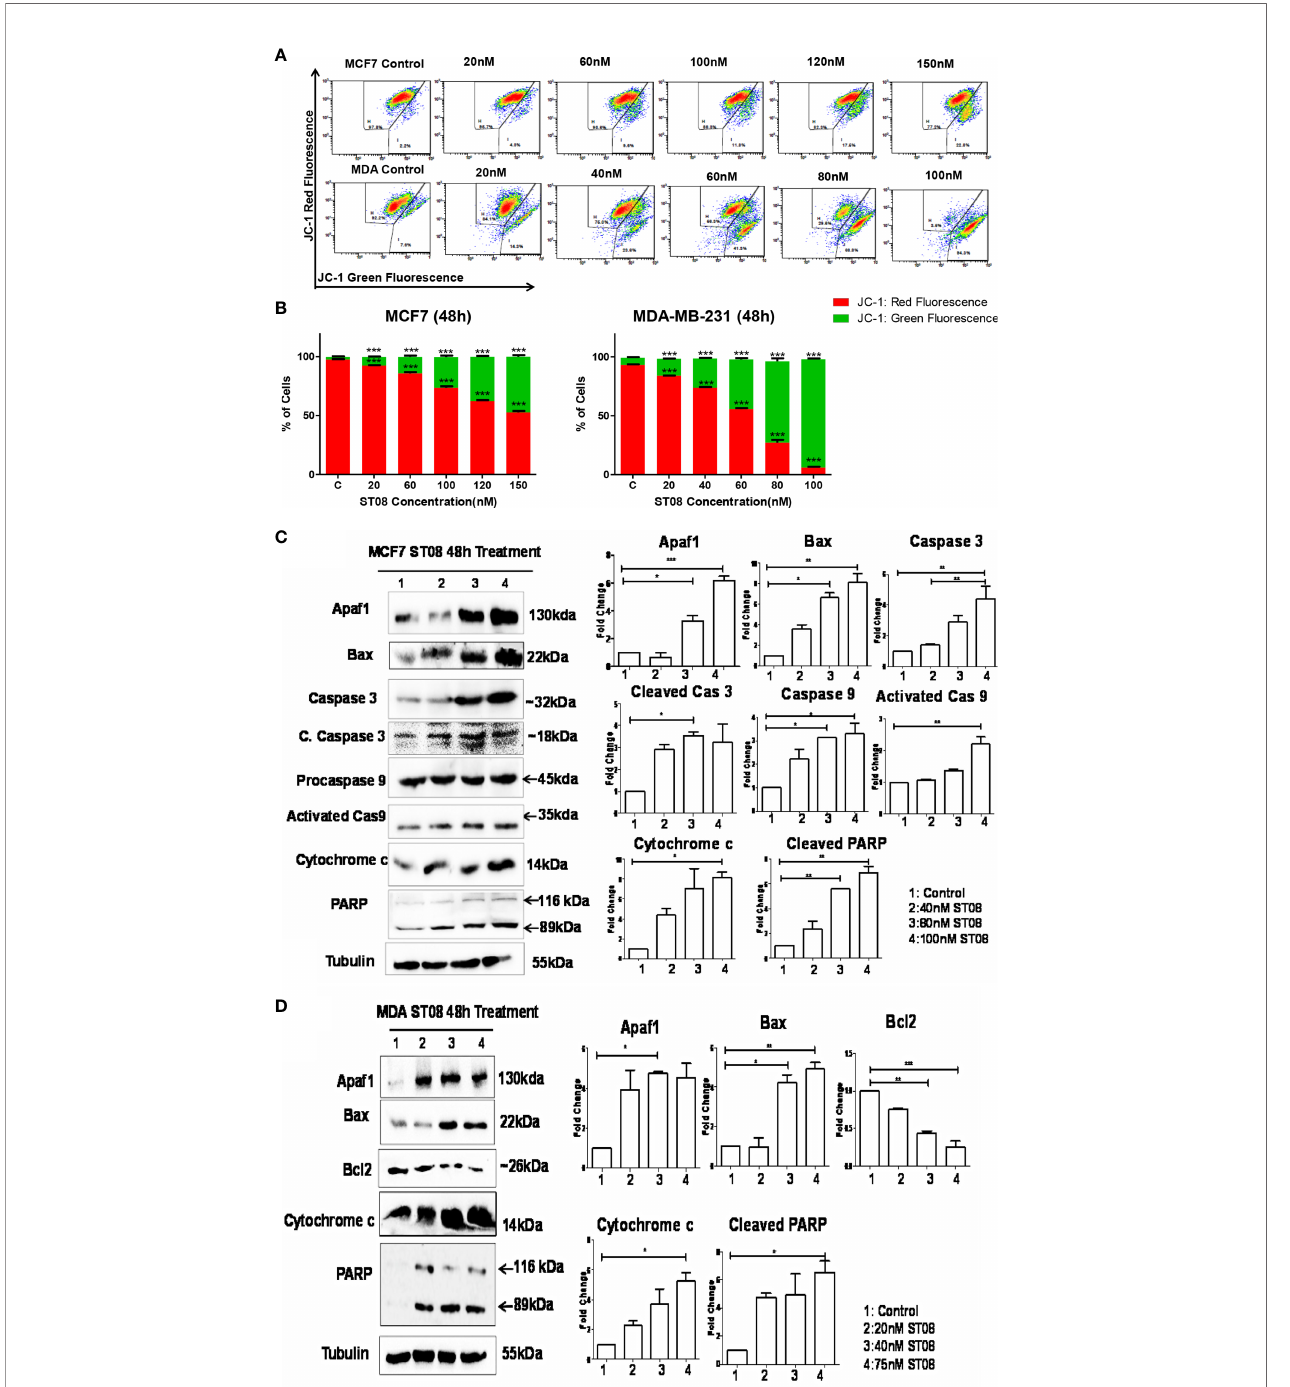
FIGURE 2 | Evaluation of mitochondrial membrane potential(MMP) changes induced in breast cancer cells by JC-1 staining and Assessment of apoptotic protein markers in breast cancer cells treated with ST08: Dot plot depicting 48h treated MCF7, MDA-MB-231 cells by ST08 subjected to JC-1 staining (A) . Quanti fi cation of high and low MMP (B) depicted as a bar graph after 48h treatment of ST08 on MCF7, MDA-MB-231 cells. Each experiment was repeated three times and represented as histograms. Two-way ANOVA test was performed and p-value was calculated between control and ST08 treated groups (*p < 0.05, **p < 0.005, ***p < 0.0001). Western blot analysis of apoptotic markers was done on ST08 treated MCF7 (C) and MDA-MB-231 (D) cell lysates. Each experiment was done in duplicates, and a representative image is shown for each marker. Quanti fi cation was done for each marker and is represented as a bar graph of mean +/- SEM. One sample t-test and one way ANOVA test was performed, and the p-value was calculated between control and ST08 treated groups (*: p -value <0.05, **: p -value